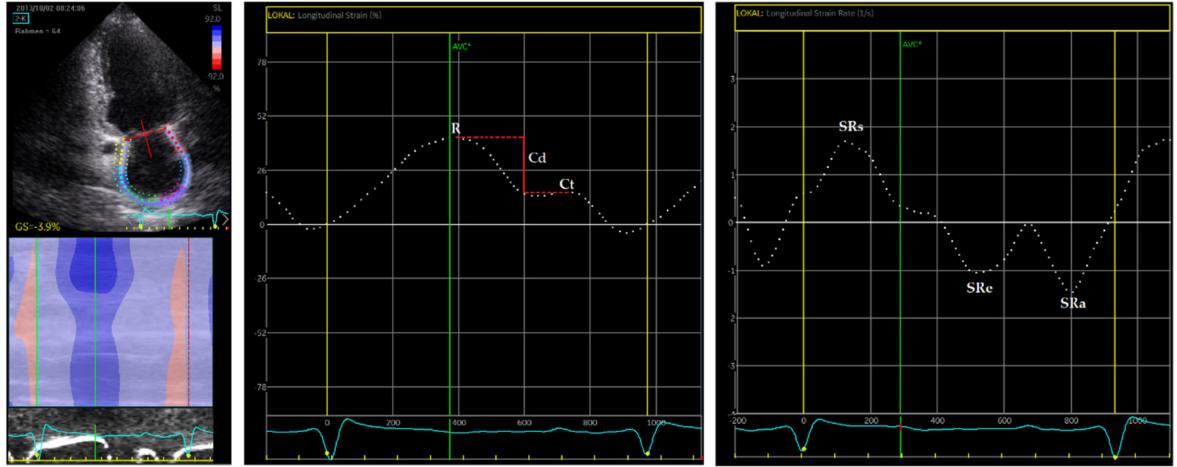
Figure 2. Example of LA strain and strain rate measurements measured in TTE two-chamber view. R—reservoir strain, Ct—contractile strain, Cd—conduit strain, SRs—reservoir strain rate, SRe—conduit strain rate, SRa—contractile strain